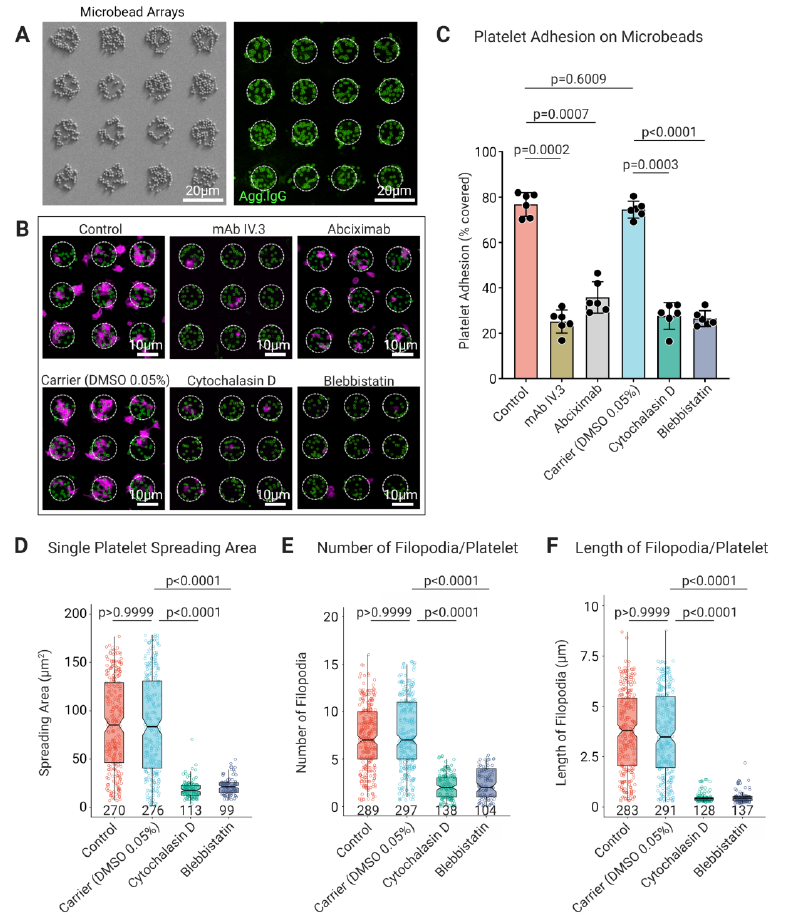
Figure 3. Platelet cytoskeletal destabilization leads to a decrease in platelet spreading on Agg-IgG functionalized ‘bacteriamimetic’ microbeads arrays due to abrogation of filopodia formation ( A ) SEM and CLSM images (detected using goat anti-human IgG Alexa 488 in green) of Agg-IgG functionalized ‘bacteriamimetic’ microbead arrays; ( B ) Representative CLSM images of platelet adhesion and ( C ) analysis of spreading area of single platelets pretreated with Fc γ RIIA blocking mAb IV.3 (4 µ g/mL), integrin α IIb β 3 blocking antibody, cytochalasin D (25 µ M), and blebbistatin (10 µ M) shows significant reduction in comparison with untreated platelets (control) and DMSO 0.05% (as a carrier) on their spreading on Agg-IgG functionalized ‘bacteriamimetic’ microbeads arrays (platelet F-actin in magenta, Agg-IgG detected using goat anti-human IgG Alexa 488 in green). Data represent mean ± SD from n = 6 donors, and statistical comparisons were performed using one-way ANOVA, followed by Tukey’s multiple comparisons test. Inhibition of platelet F-actin polymerization by cytochalasin D (25 µ M) and myosin II ATPase inhibitor blebbistatin (10 µ M) significantly reduces ( D ) spreading area, ( E ) number, and ( F ) length of filopodia in single platelets in comparison with untreated platelets (control) and DMSO 0.05% (as carrier) on Agg-IgG functionalized ‘bacteriamimetic’ microbeads arrays. Statistical comparisons were performed by one-way ANOVA on ranks (non- parametric) followed by Dunn’s multiple comparisons test. Boxplots extend from 10 to 90 percentiles, and p < 0.05 is